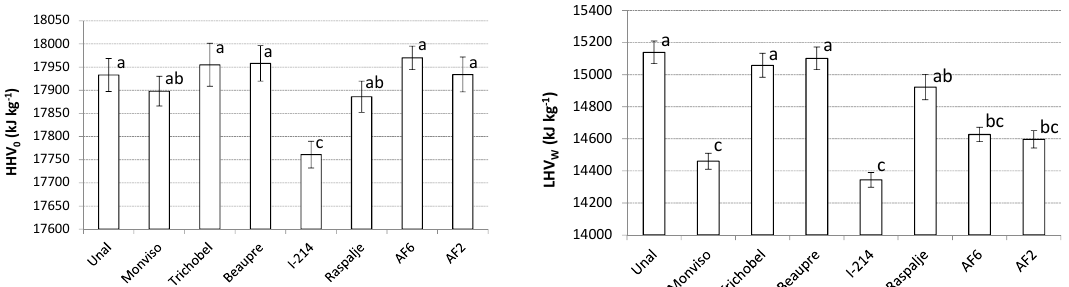
Figure 2. Mean and standard errors of the dry higher heating value (HHV 0 , left) and the low heating value at the boiler (LHV W , right) for the eight genotypes studied. Different letters denote significant differences (Tukey test).